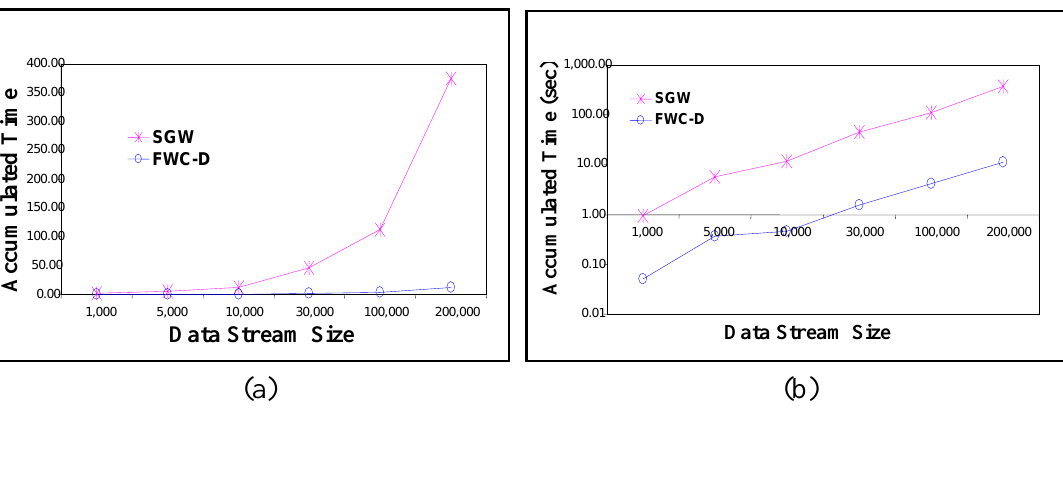
Figure 12. Accumulated execution time of the Integrity check algorithm at the receiver sensor. ( a ) Linear Scale ( b ) Logarithmic